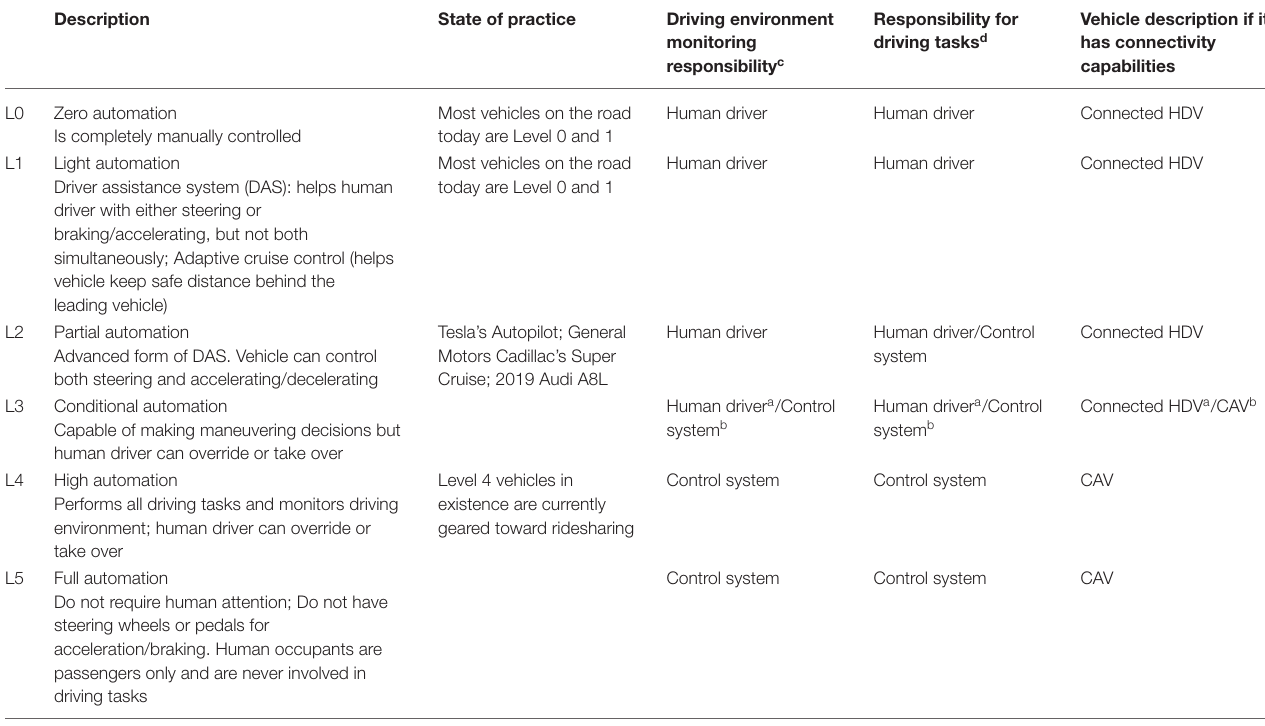
TABLE 1 | SAE Levels of autonomy, driving task responsibility, and connectivity